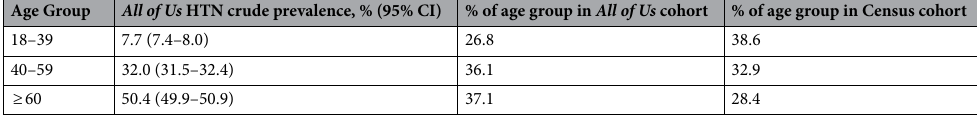
Table 2. Crude HTN Prevalence in All of Us Research Program with Age Distribution in All of Us Compared with the U.S. Census (2018) 1 . 1 https:// www. census. gov/ newsr oom/ press- kits/ 2019/ detai led- estim ates. html.